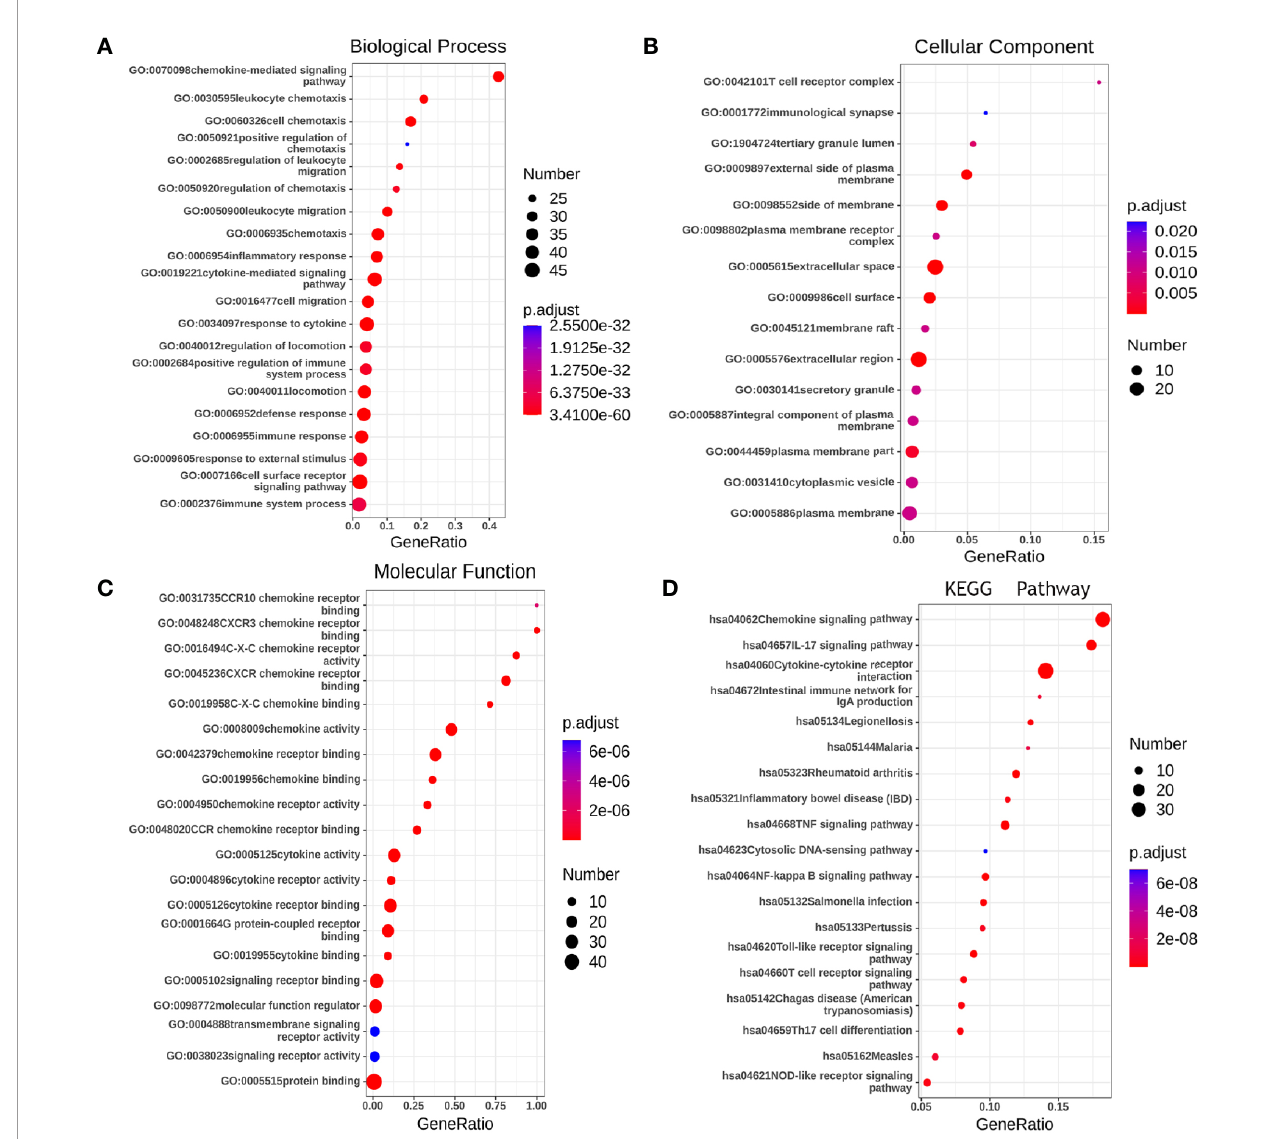
FIGURE 10 | The functions of CXCRs and neighborhood genes predicted by GO and KEGG analysis by String. (A) Biological Process. (B) Cellular Component. (C) Molecular Function. (D) KEGG